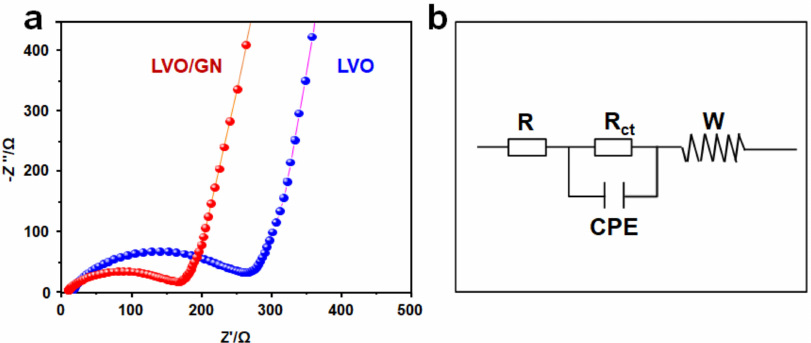
Figure 5. ( a ) Nyquist plots of LVO and LVO/GN. ( b ) The equivalent circuit